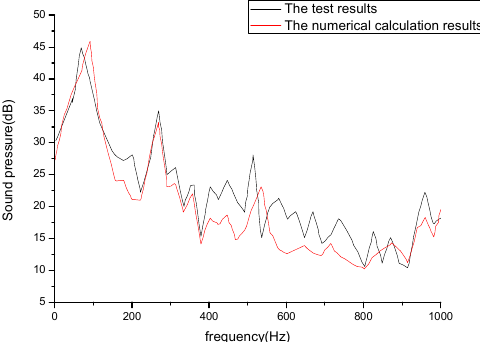
Figure 3. Comparison of results between the experimental test and numerical simulation. The dark line shows the results of the preliminary test, and the red line shows the results of numerical calculation. The horizontal axis denotes the frequency in the range from 0 to 1 kHz, and the longitudinal axis indicates the sound pressure level with a reference of 20 μ Pa.